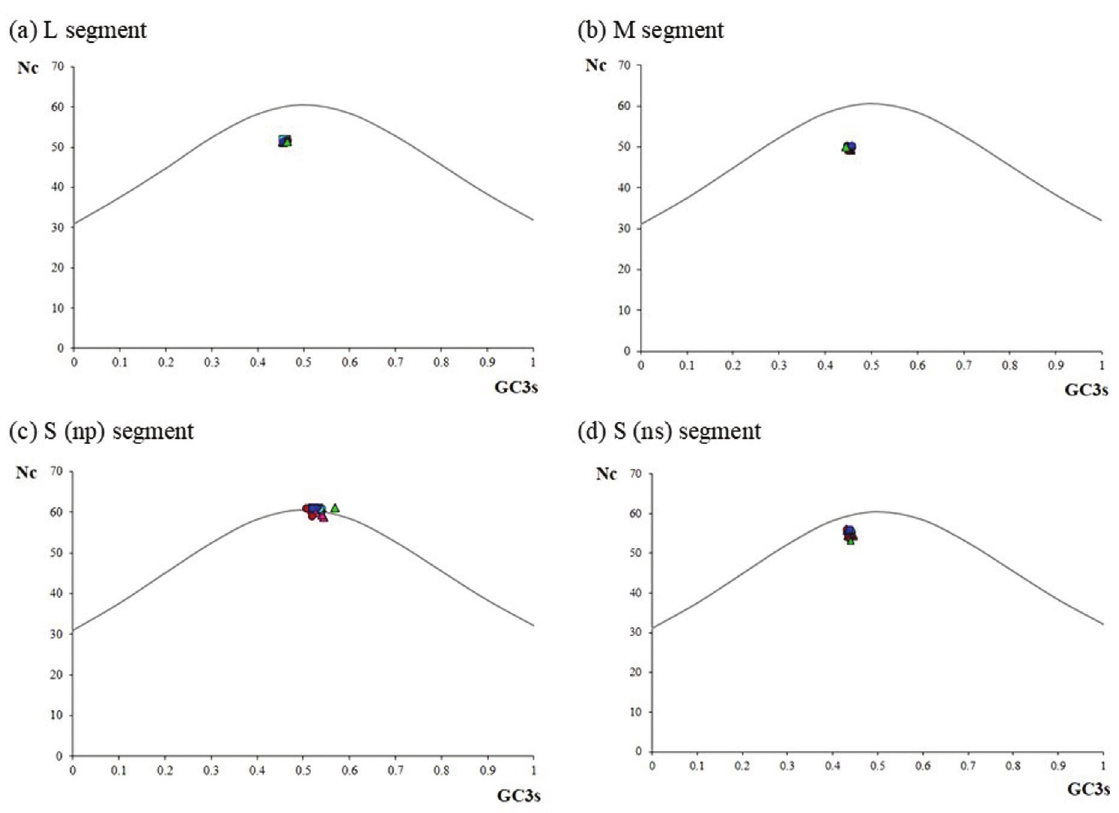
Figure 2 - ENC versus GC3 plots for RVFV segments; (a) L segment, (b) M segment, (c) S (np) segment, (d) S (ns) segment ENC plotted against GC3 of the CDS regions in the L, M and S (NS) segments are distributed below the curve, which means that codon usage is biased. In the S (NP) segment, the ENC values are distributed above the curve, showing that codon usage is more